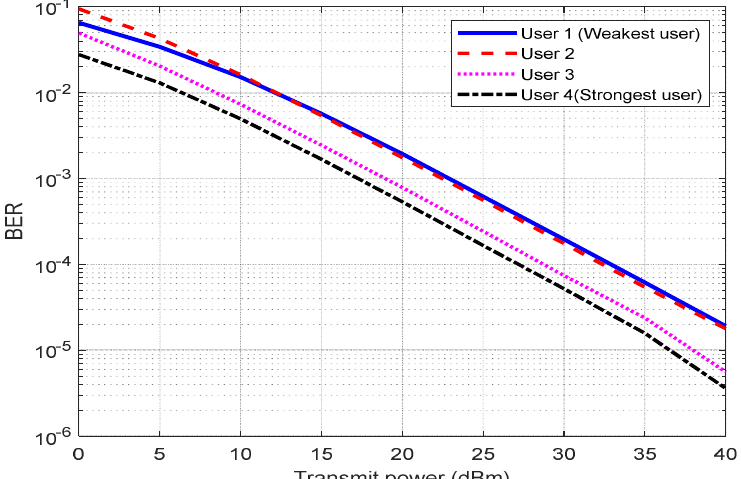
Figure 5. BER vs. transmitting power for four users with varying distances and power coefficients, for DL NOMA at BW (80 MHz with 64 × 64 MIMO for DL NOMA.